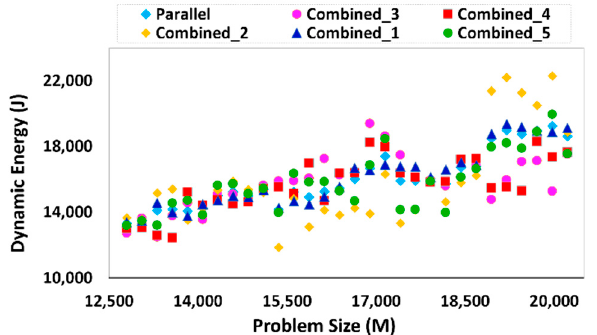
Figure 9. Dynamic energy profiles in set of energy profiles (EPS) DGEMM_AnMoHA.